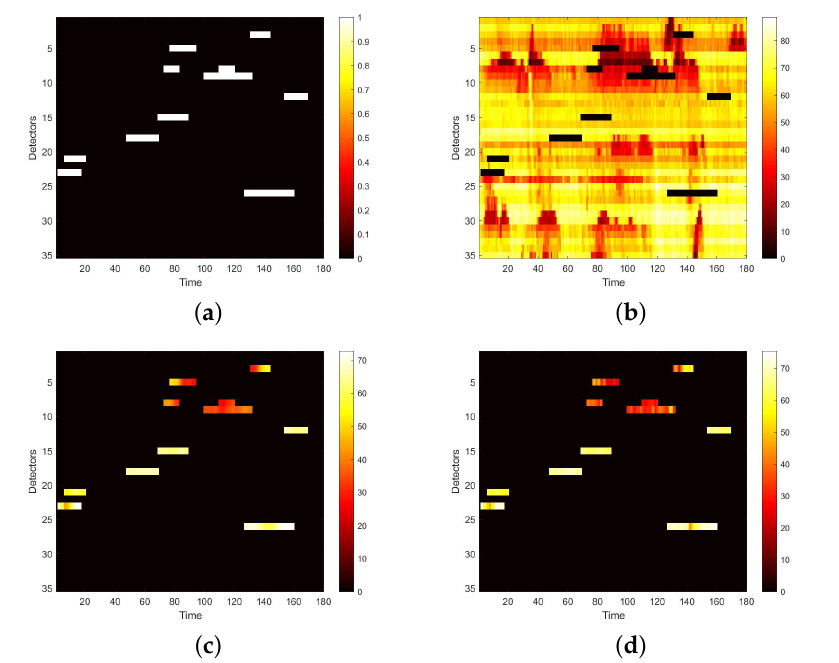
Figure 9. Speed matrices of Yan’an elevated highway (the 1st day of testset) with strip damage visualized as heat maps. ( a ) Mask matrix visualized as a heat map. ( b ) Damaged speed matrix visualized as a heat map. ( c ) Repaired speed matrix visualized as a heat map. ( d ) Real speed matrix visualized as a heat